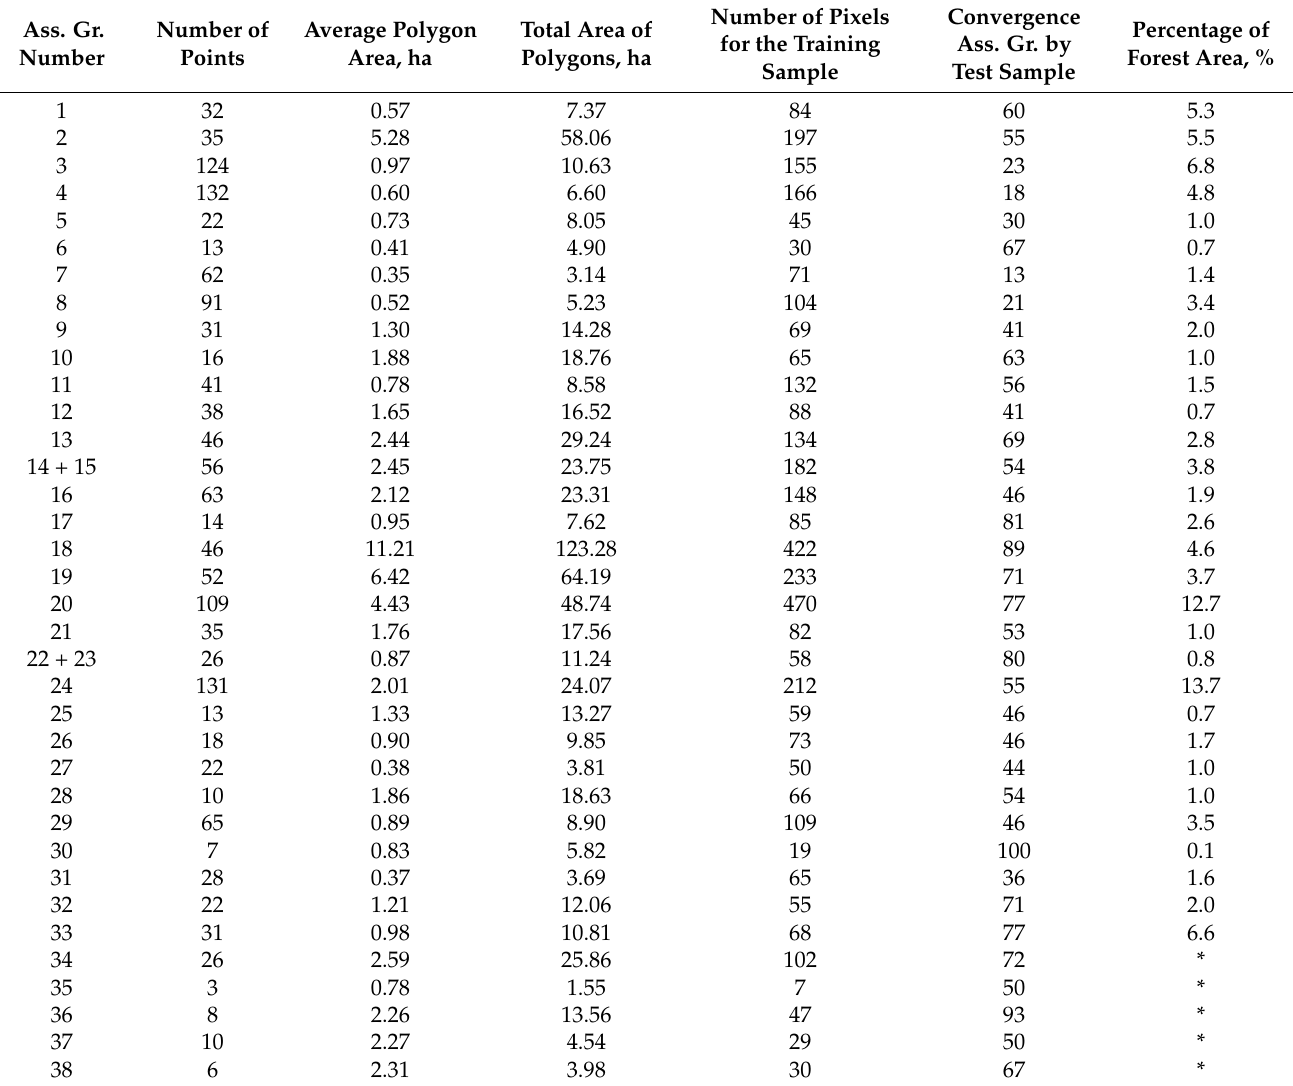
Table A4. Analysis of the size of the training